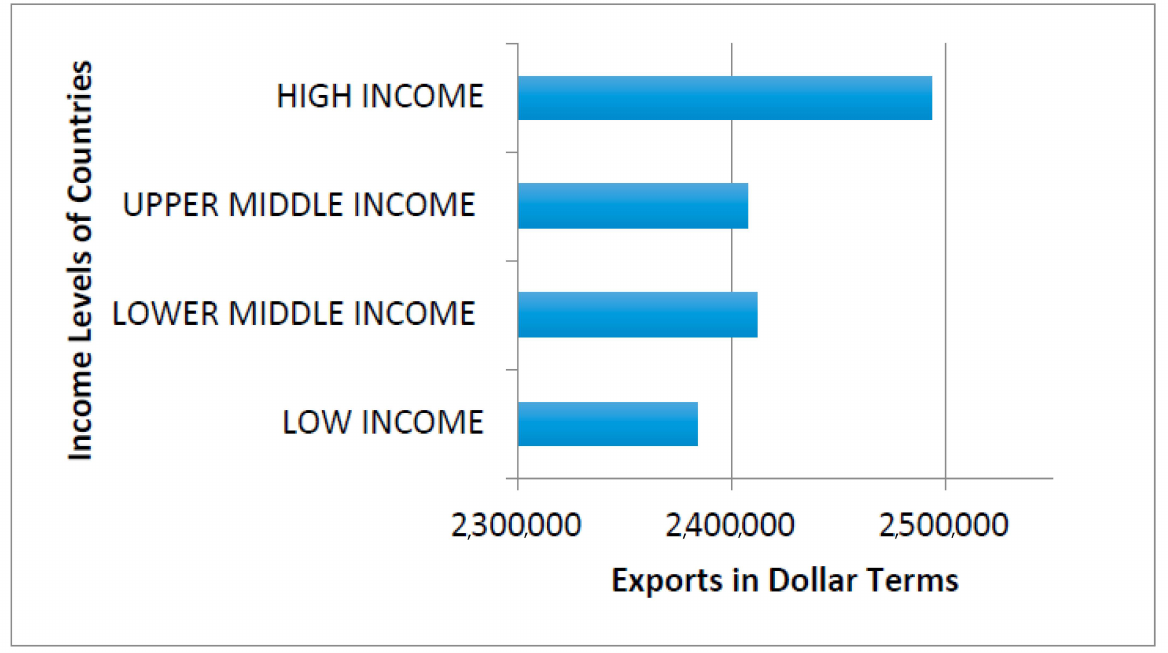
Figure 2. Export of agricultural commodities (USD). Source: FAO and UNCTAD Trade and Invest- ment Report. Table 1. Foreign Direct Investment Inflow in Agriculture, Forestry, and Fishing in Developing Countries (USD,